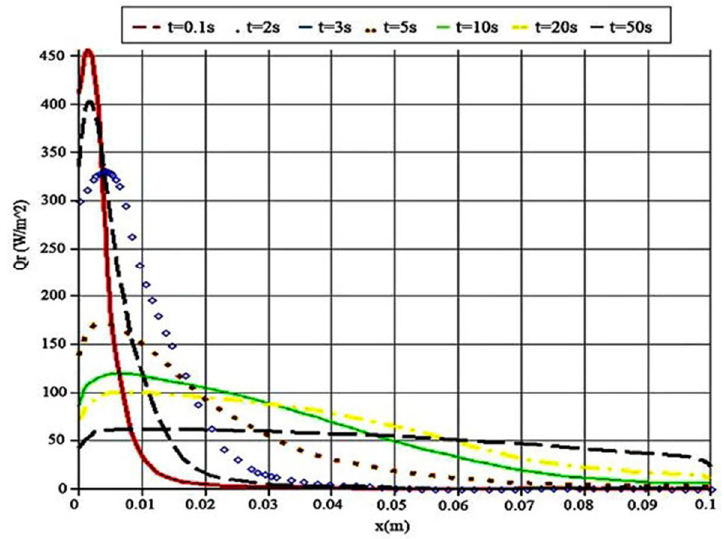
Figure 6. Radiative heat flux in various time steps.